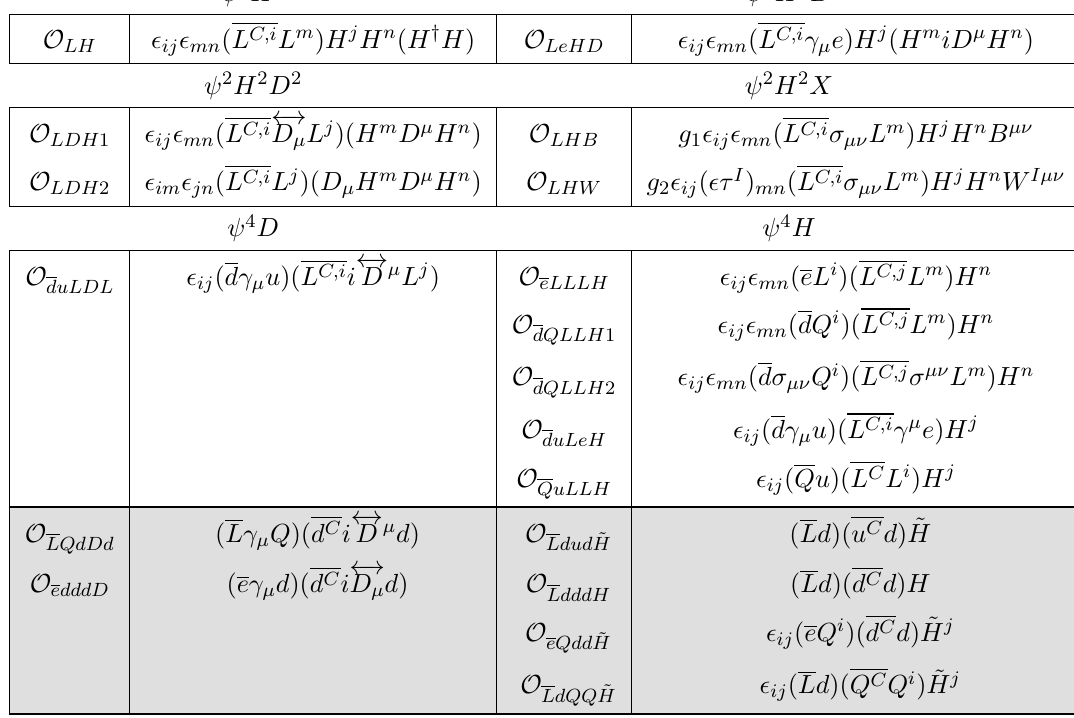
Table 3 . Basis of dim-7 operators in SMEFT [37]. Here L; Q are the left-handed lepton and quark doublet (cid:12)elds, u; d; e the right-handed up-type quark, down-type quark and charged lepton singlet (cid:12)elds, and H the Higgs doublet with ~ H i = (cid:15) ij H j . Color contraction is implied for triple quark (cid:12)elds. The operators in gray have ((cid:1) L; (cid:1) B ) = ( (cid:0) 1 ; 1) while others have ((cid:1) L; (cid:1) B ) = (2 ; 0). Hermitian conjugate operators are not